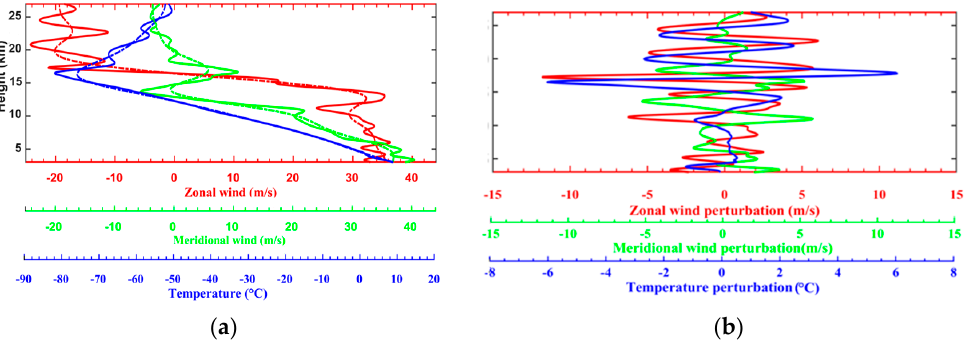
Figure 10. ( a ) Vertical profiles of zonal (solid red) and meridional wind (solid green), and temperature (solid blue) at location (22° N, 124.3° E) in region C. Mean vertical profiles (dash-dotted) are retrieved using a fourth-order Butterworth low-pass filter with a 7 km wavelength cutoff. ( b ) Temperature and horizontal wind perturbations.